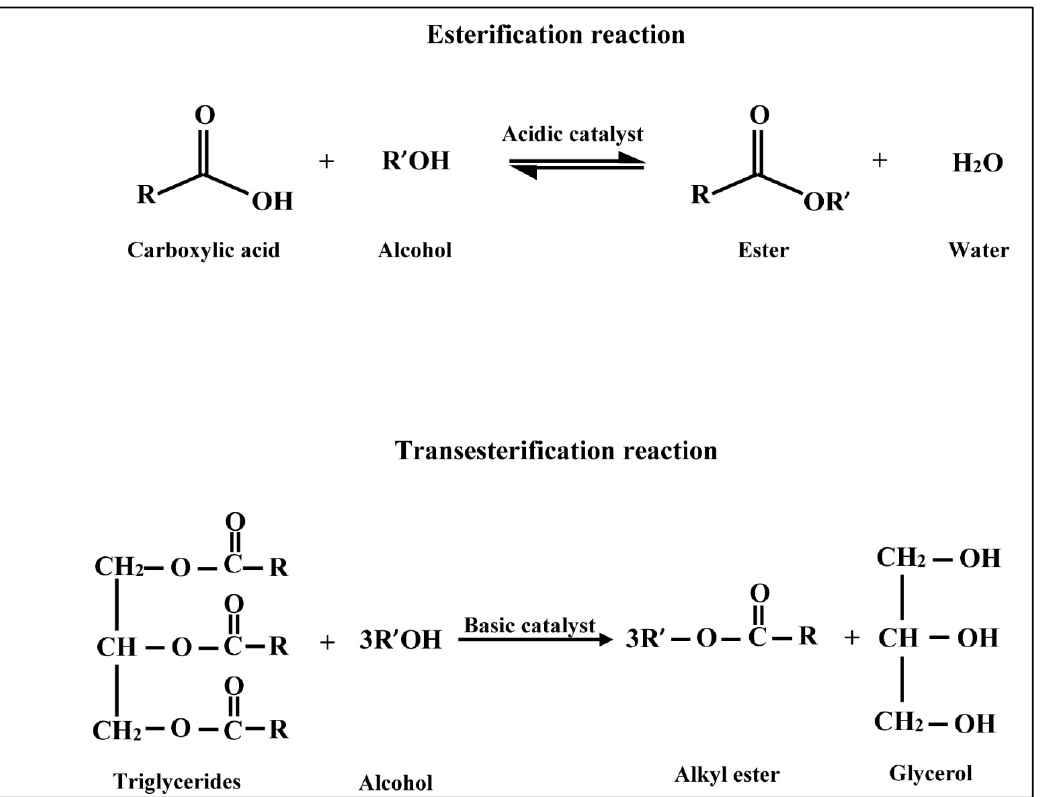
Figure 4. Esterification/Transesterification reactions to produce biodiesel